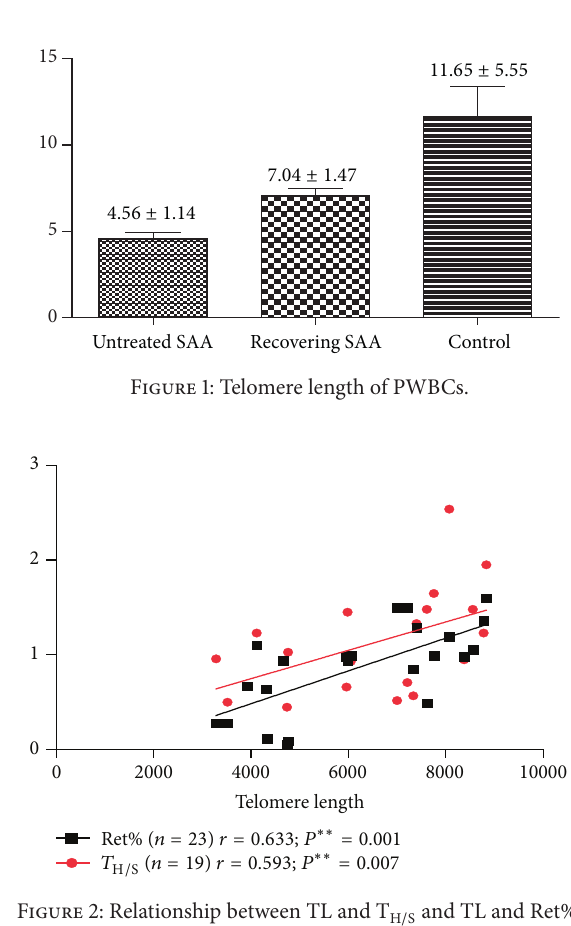
Figure 2: Relationship between TL and T H / S and TL and Ret%.